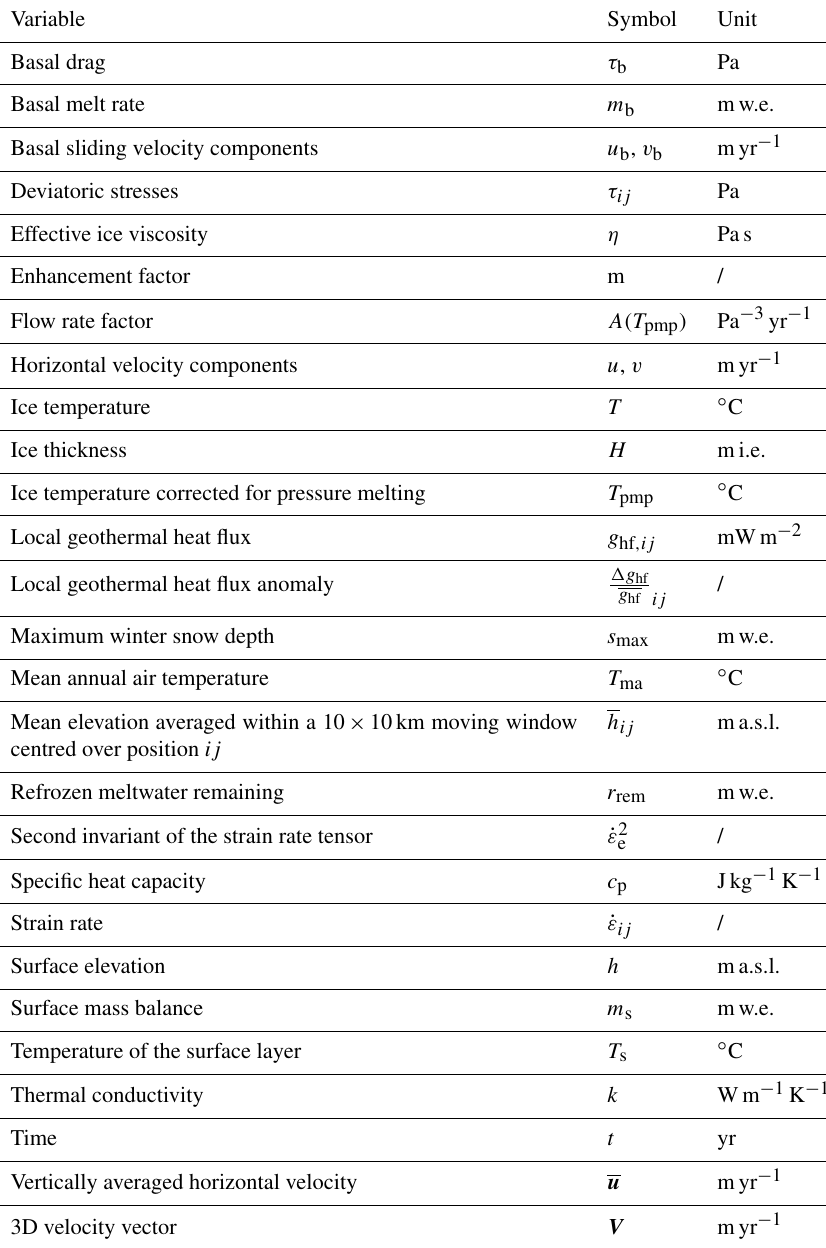
Table 1. Variables and constants and their symbols, values, and units. ST refers to the Sary-Tor glacier, while GR stands for the Grigoriev ice